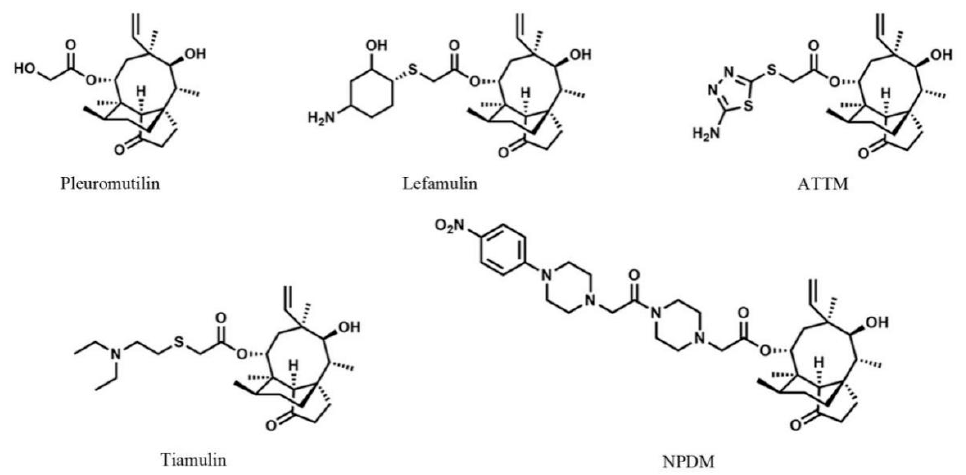
Figure 1. Structure of pleuromutilin, lefamulin, ATTM, tiamulin, and NPDM.